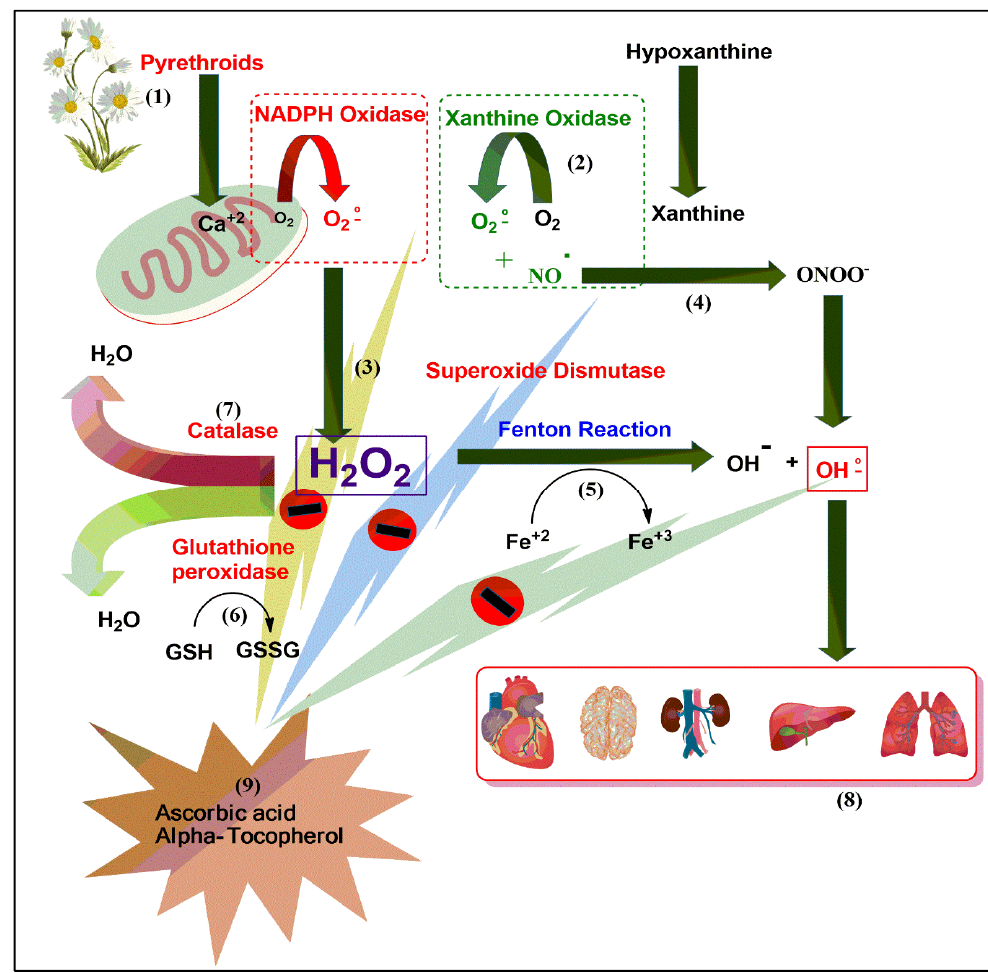
Figure 12. The oxidative stress cascade mechanism illustrating the toxicity generation sequence and the AA and E307 inhibitory actions on the free